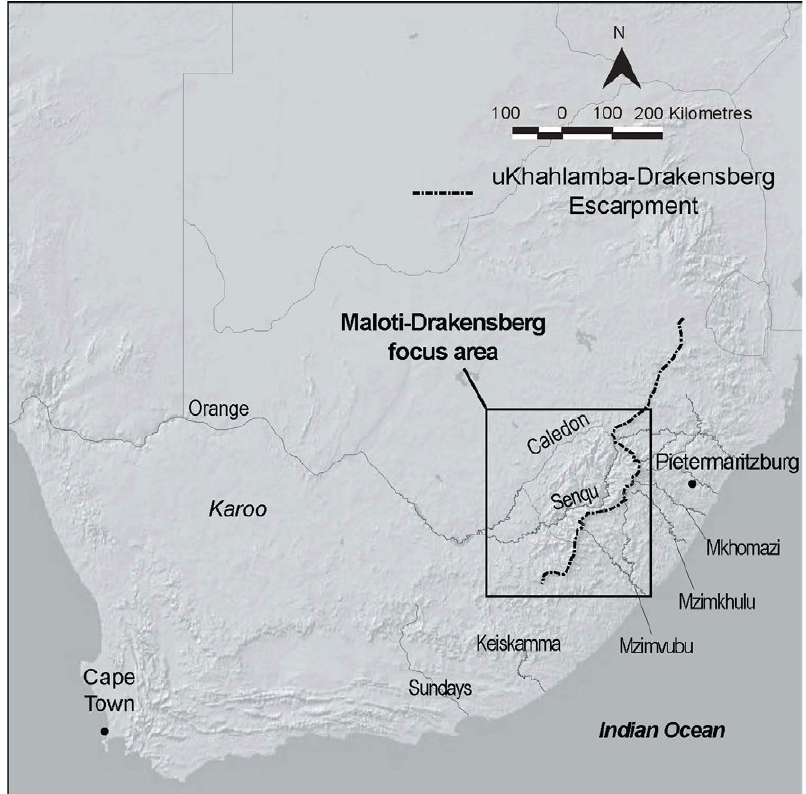
Figure 1: Map of southern Africa showing Maloti-Drakensberg study area. Map created using ArcGIS® software by Esri. ArcGIS® and ArcMap™ are the intellectual property of Esri and are used herein under license. Copyright © Esri. All rights